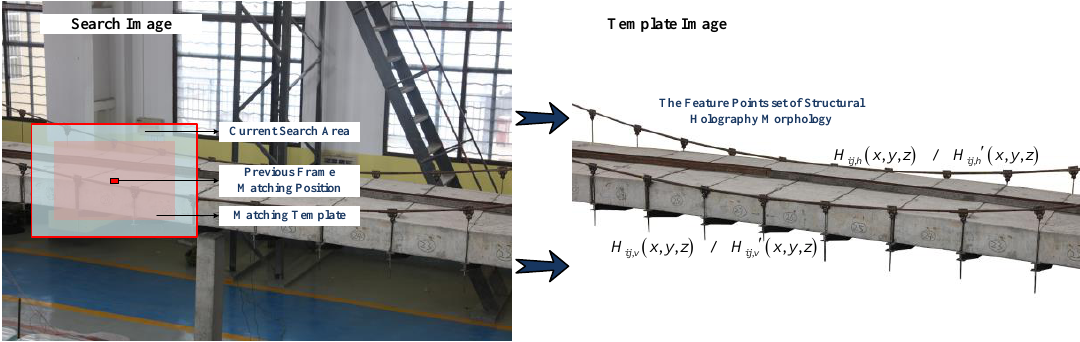
Figure 3. Matching schematic diagram.